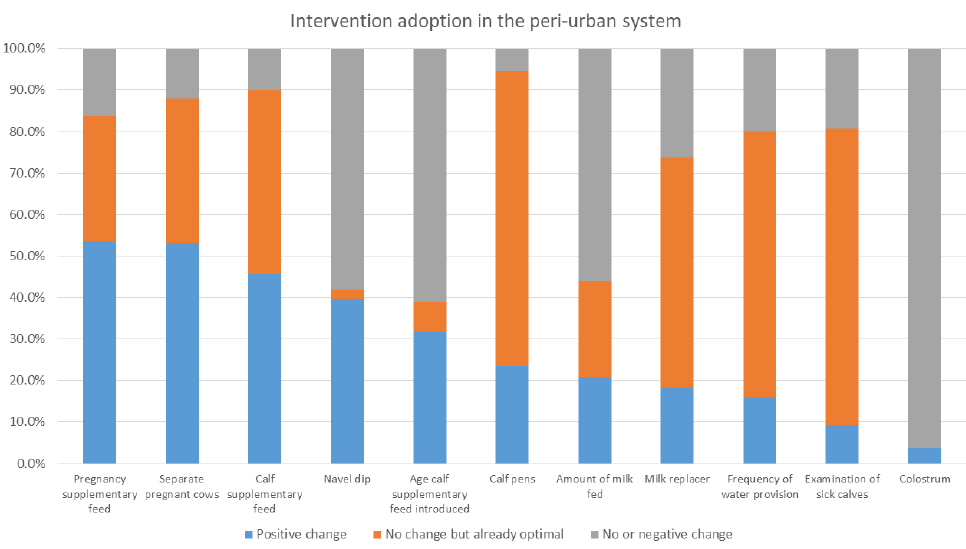
Figure 5. The proportion of enrolled peri-urban households with baseline and final evaluation data with either (a) no change in intervention area practices during the study period but were already optimal at the start of the study, (b) positive change, or (c) no or negative change in intervention areas.